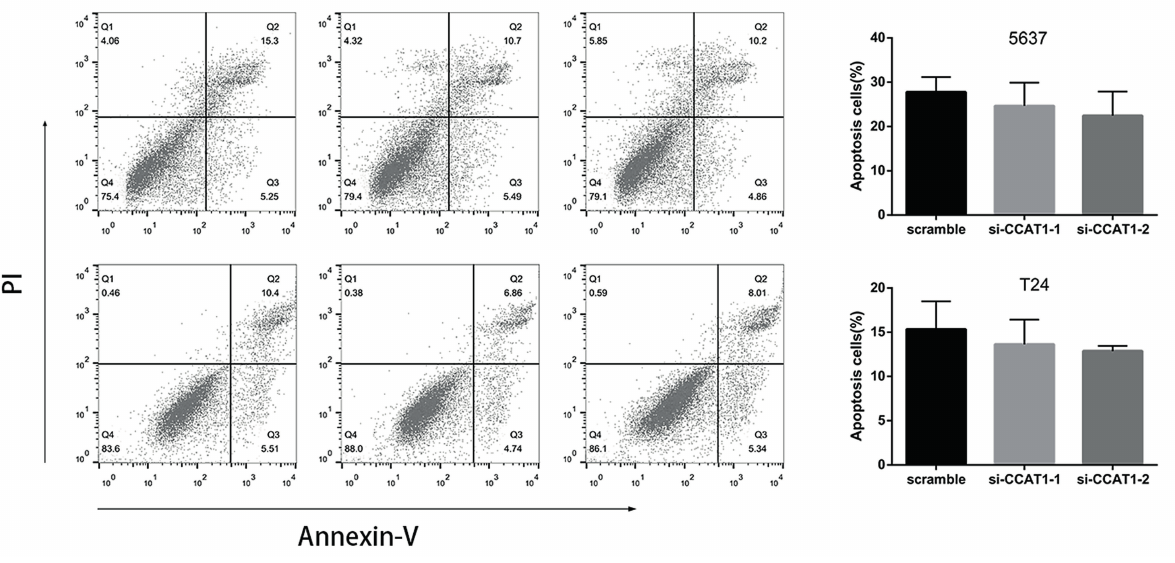
Data are represented as mean ± SD. *Indicates